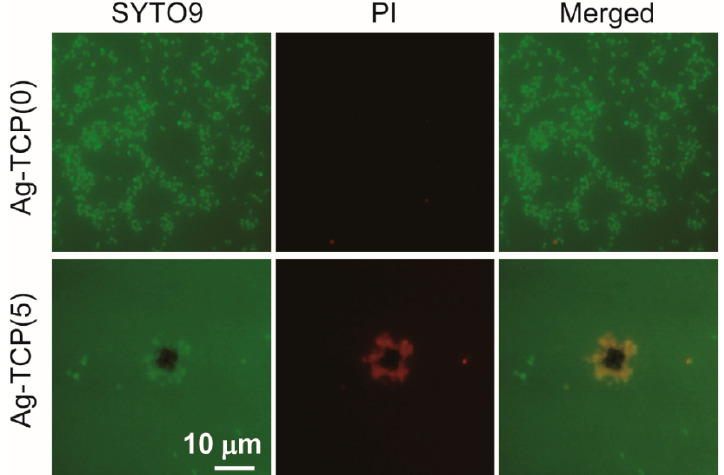
Figure 8. In vitro evaluation of antimicrobial activity by biofilm formation assay. Fluorescence in micrograph (LIVE/DEAD staining) of Ag-TCP(0) and Ag-TCP(5) cements surface after in vitro biofilm formation. Vital bacteria appear green (SYTO9) and dead bacteria appear red (PI). Right panels represent merged image of SYTO9 and PI. Bar indicates 10 μ m.